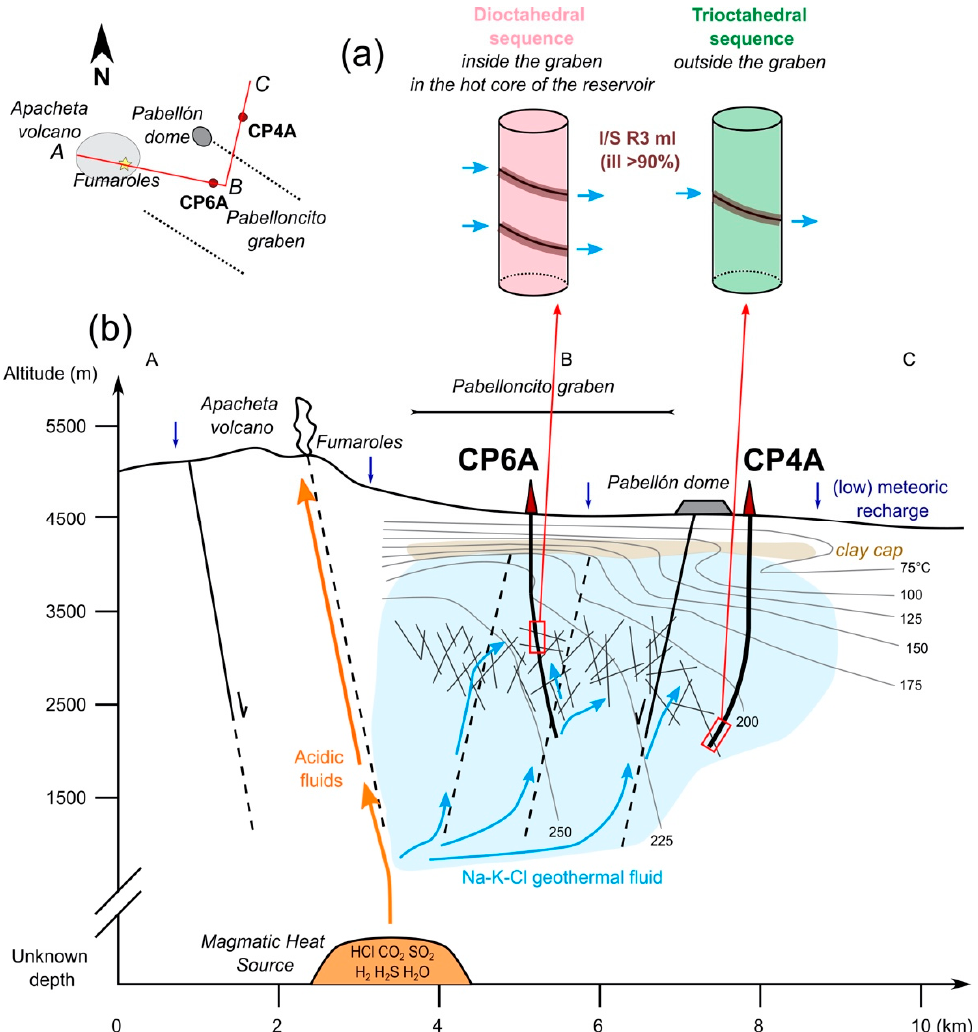
Figure 8. ( a ) Clay signature of the deep fluid circulations in Cerro Pabellón (CP) wells. ( b ) Conceptual model of the CP geothermal system after [4,6,7,33]. Isotherms, structures, and fluid circulations are schematically represented and updated with our results in the CP-4A and CP-6A wells. The large-scale faults are from the structural model of [24] and the fractured core of the reservoir follows the trace of the low resistive anomaly in the 3D magnetotelluric model from [34]. The depth of the magmatic heat source is from [54].